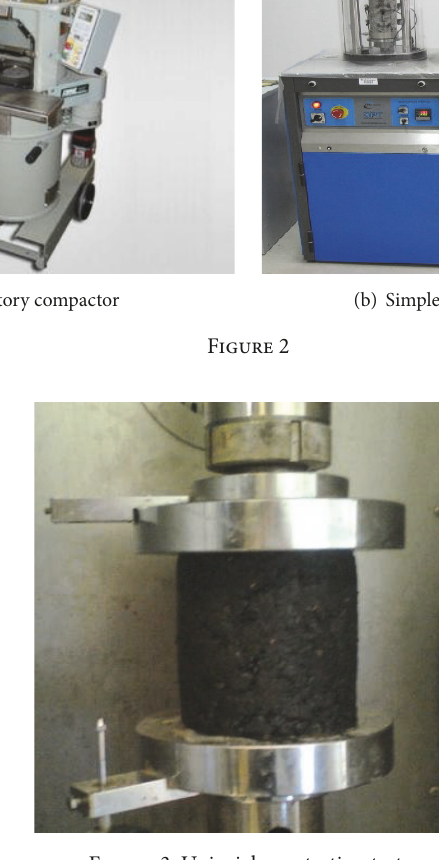
Figure 3: Uniaxial penetration